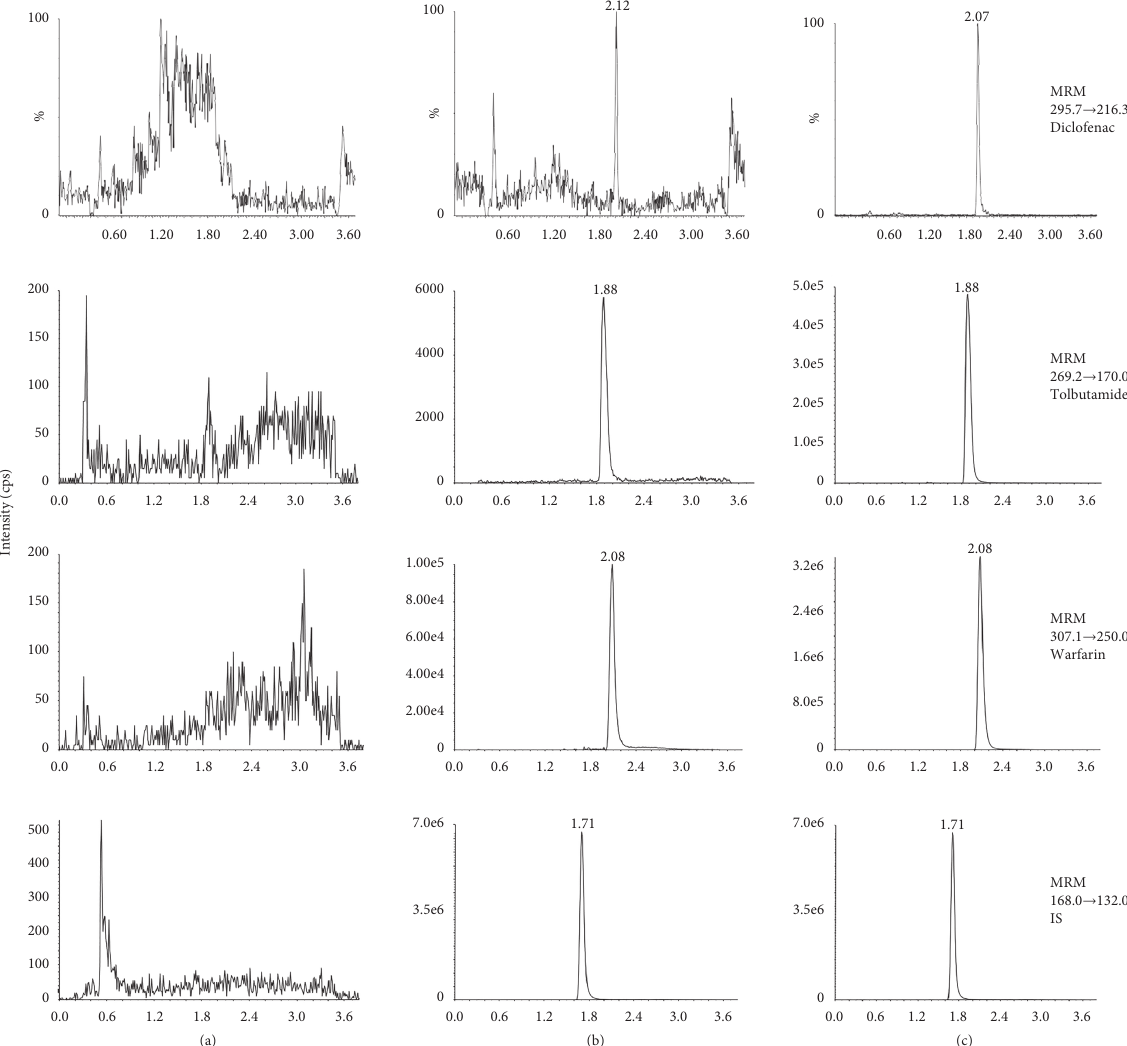
Figure 2: MRM chromatograms of diclofenac, tolbutamide, warfarin and chlorzoxazone (IS) from rat plasma. (a) Blank rat plasma; (b) Blank plasma samples spiked with standard substance (LLOQ) and IS; (c) Real plasma samples obtained from a rat following administration of 2 mg/kg diclofenac, 30 mg/kg tolbutamide, and 2 mg/kg warfarin. Table 3: Analytical curves, correlation coefficient ( r ), linear range, and LLOQ of diclofenac, tolbutamide, and warfarin Compounds Analytical curves r Linear range ( μ g/mL) LLOQ ( μ